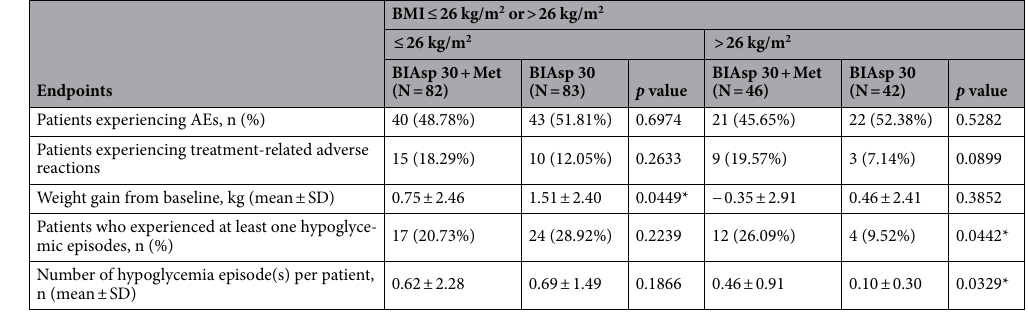
Table 4. Effect of body mass index (BMI) (≤ 26 kg/m 2 and > 26 kg/m 2 ) on safety profiles of patients receiving biphasic insulin aspart 30 (BIAsp 30) and metformin combination therapy or BIAsp 30 monotherapy (SS). BMI body mass index, SS safety set, AEs adverse reaction, SD standard deviation, FPG fasting plasma glucose. * p <